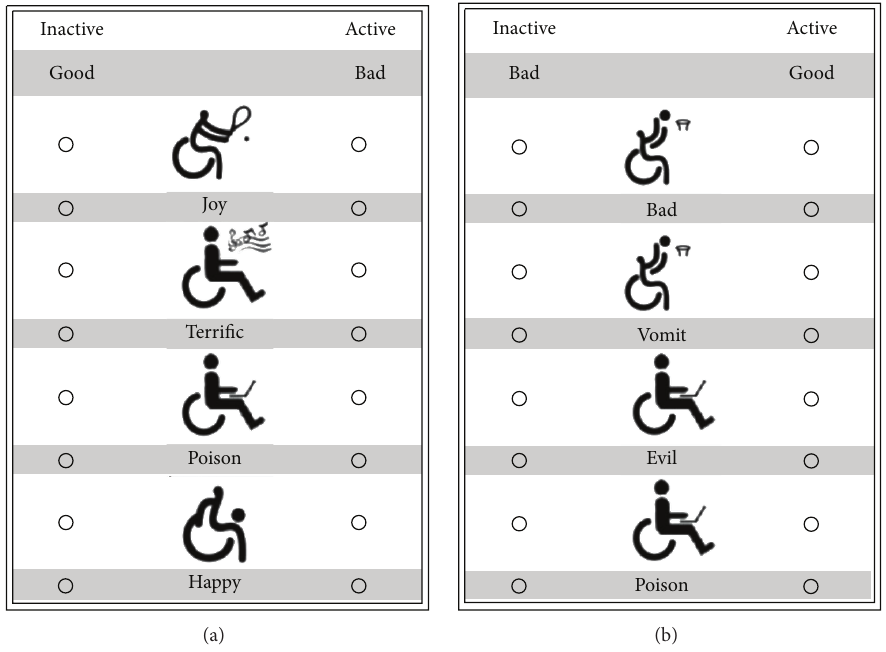
Figure 1: Example of the incongruent (a) and congruent (b) block of the Disability-Activity